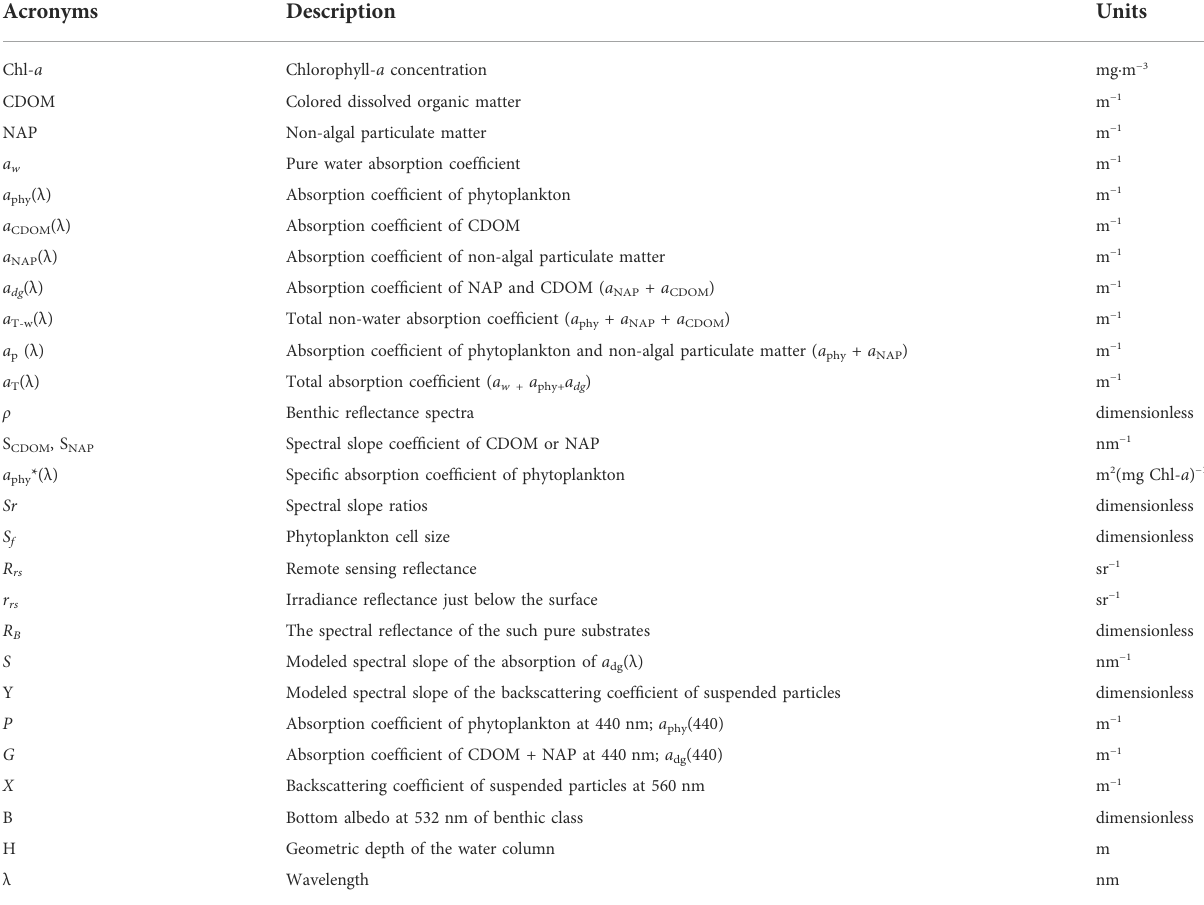
TABLE 1 Acronyms, units, and de fi nitions of the parameters referred to in this study.